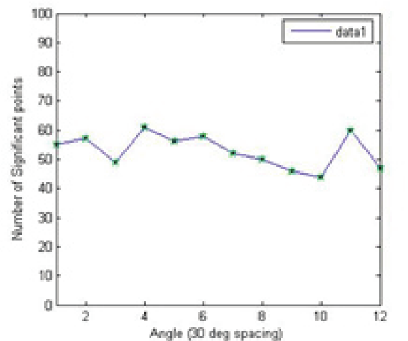
Fig.10. Repeatability rate of feature points (rotation) The feature points have been extracted for different Gaussian blurs as shown in figure 11. We have taken scales at multiples of (cid:958) 2 . Repeatability rates shown in figure 12 indicates that the feature points are robust (cid:87)(cid:82)(cid:3)(cid:86)(cid:70)(cid:68)(cid:79)(cid:72)(cid:86)(cid:3)(cid:88)(cid:83)(cid:87)(cid:82)(cid:3)(cid:305)(cid:3)(cid:32)(cid:21) (cid:958) 2 .